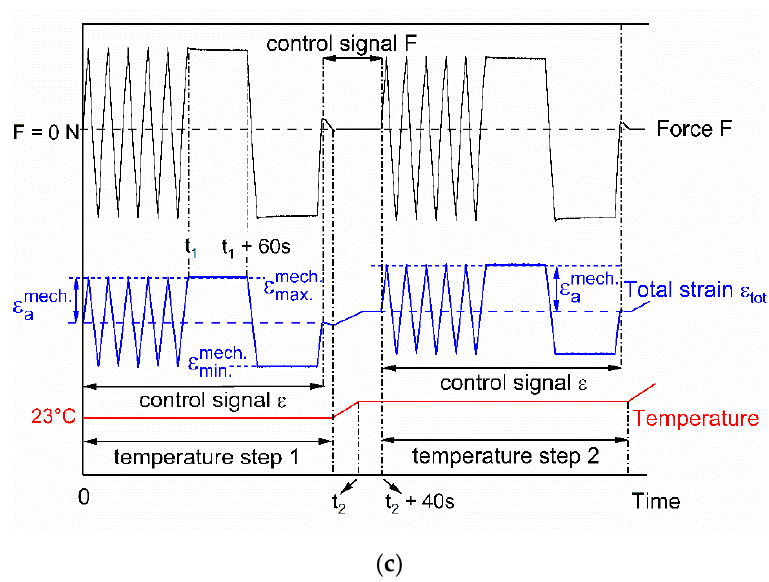
Figure 2. The loading strategies of ( a ) experiment A; ( b ) experiment B; ( c ) experiment C.